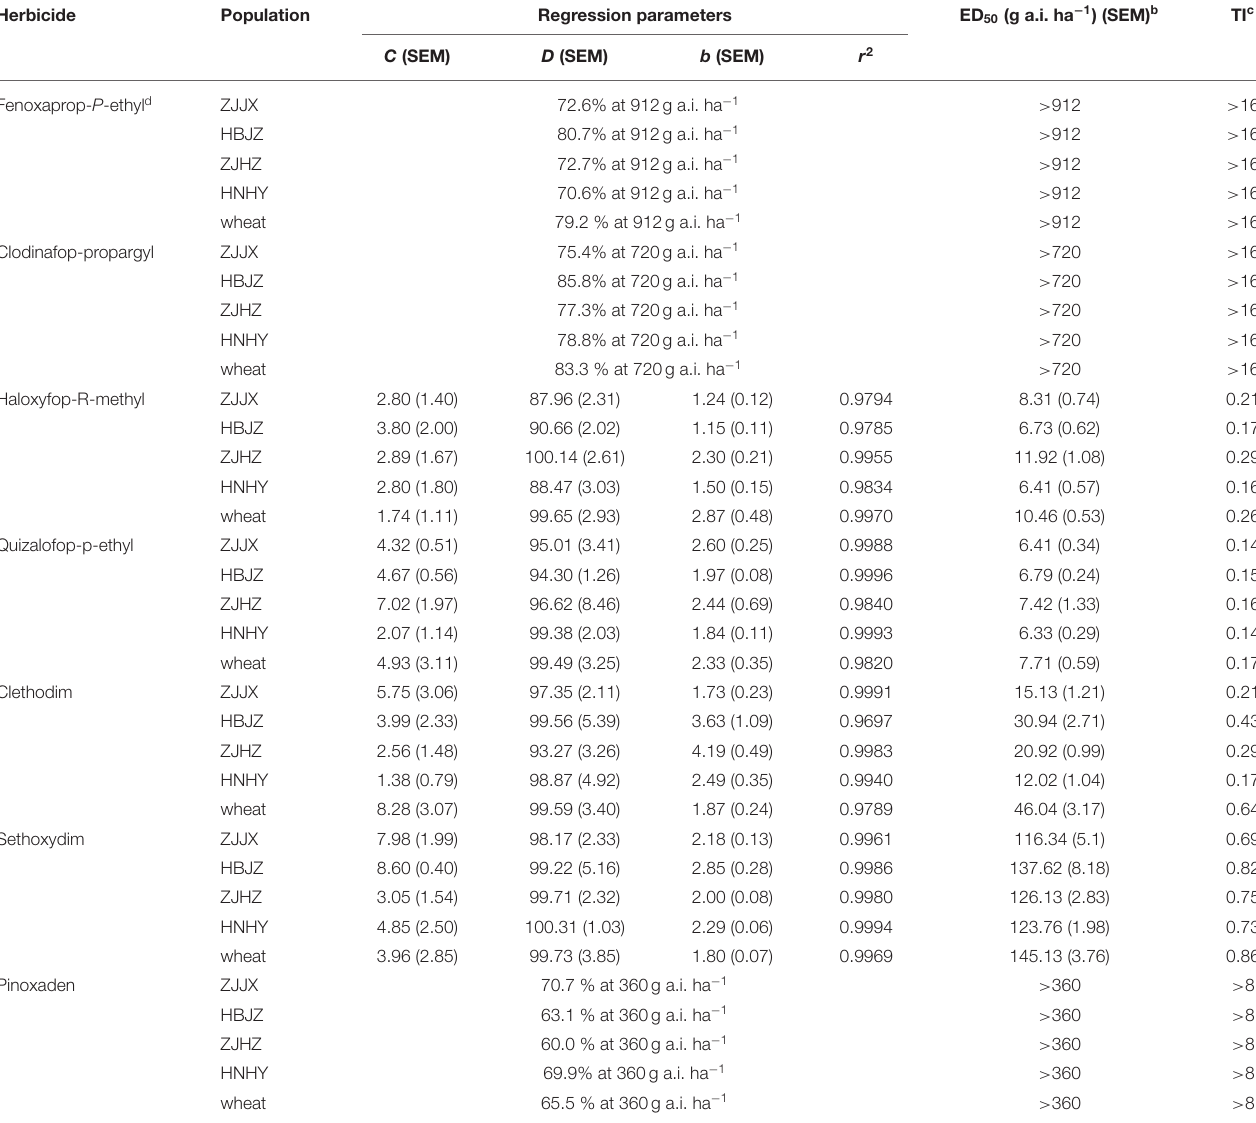
TABLE 3 | Dose–response parameters of log-logistic function (Eqn. 1 a used to fit the plant fresh weight data (as a percent of the control) for common roegneria populations treated with different ACCase inhibitors.